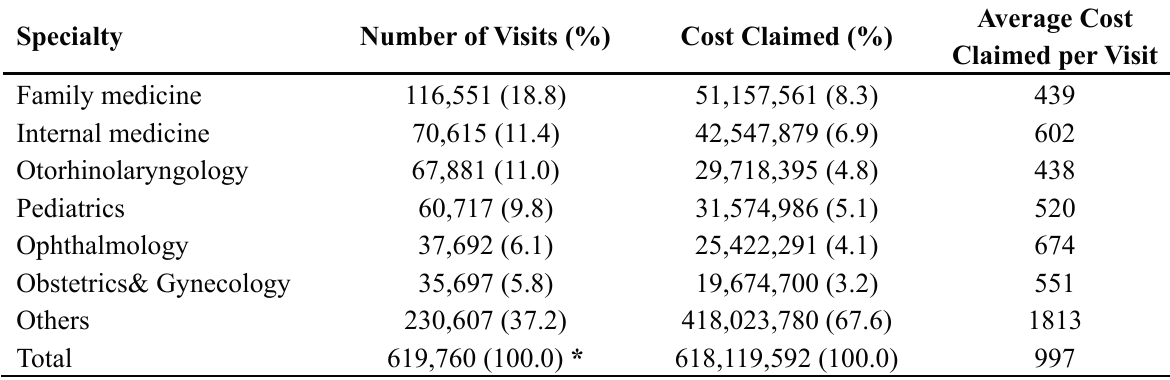
Table 1. Ambulatory visits covered by Taiwan’s National Health Insurance in 2012, stratified by specialty (sampling rate: